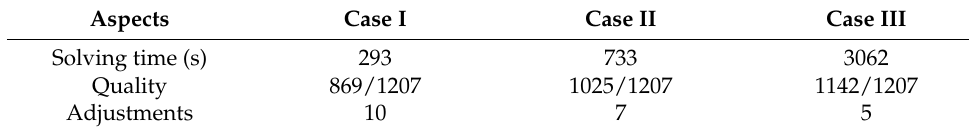
Figure 17. The iteration diagram. Table 10. Specific values of 30, 50, 80 initial feasible solutions.